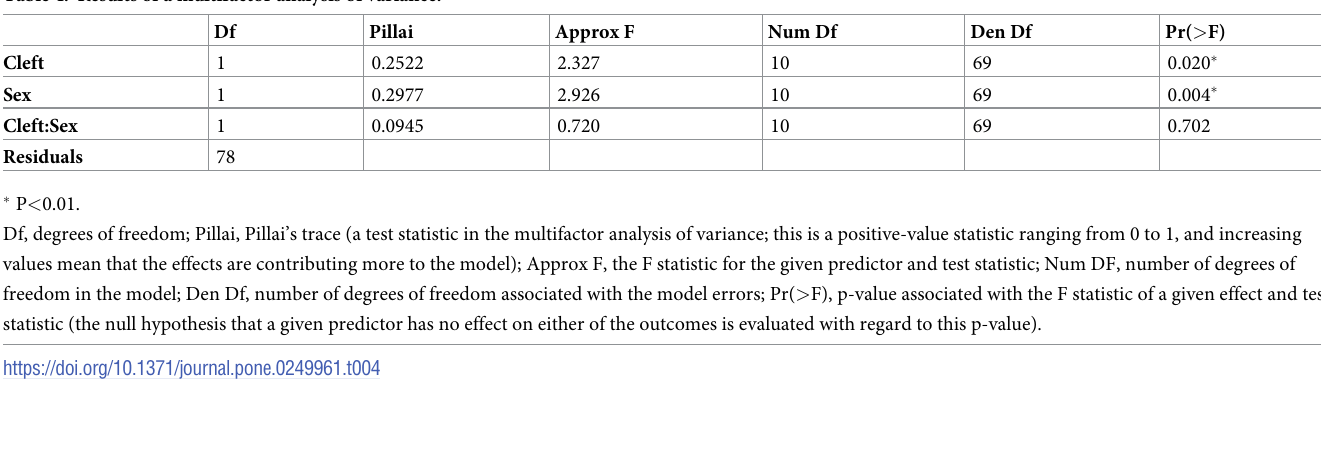
Table 4. Results of a multifactor analysis of